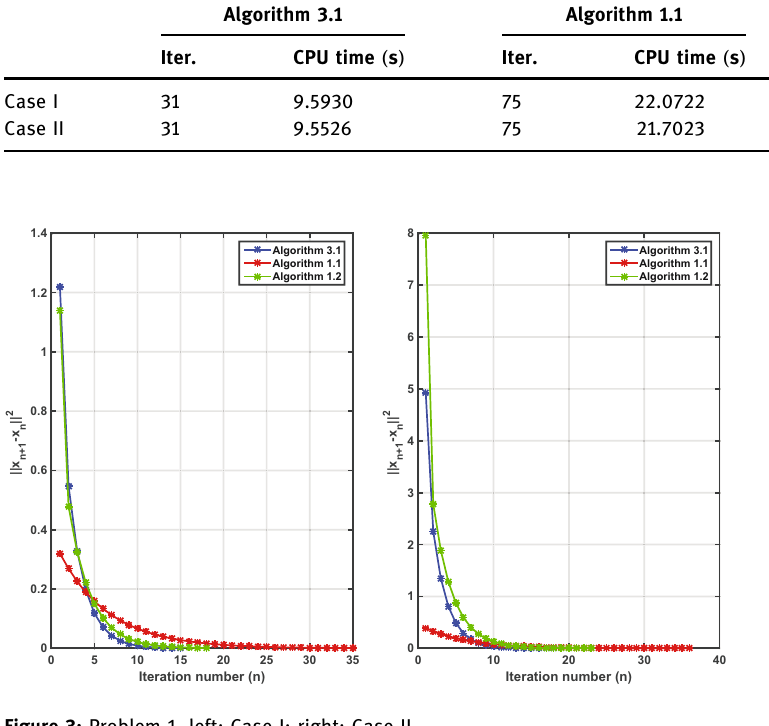
Algorithm 3.1 Algorithm 1.1 Algorithm 1.2